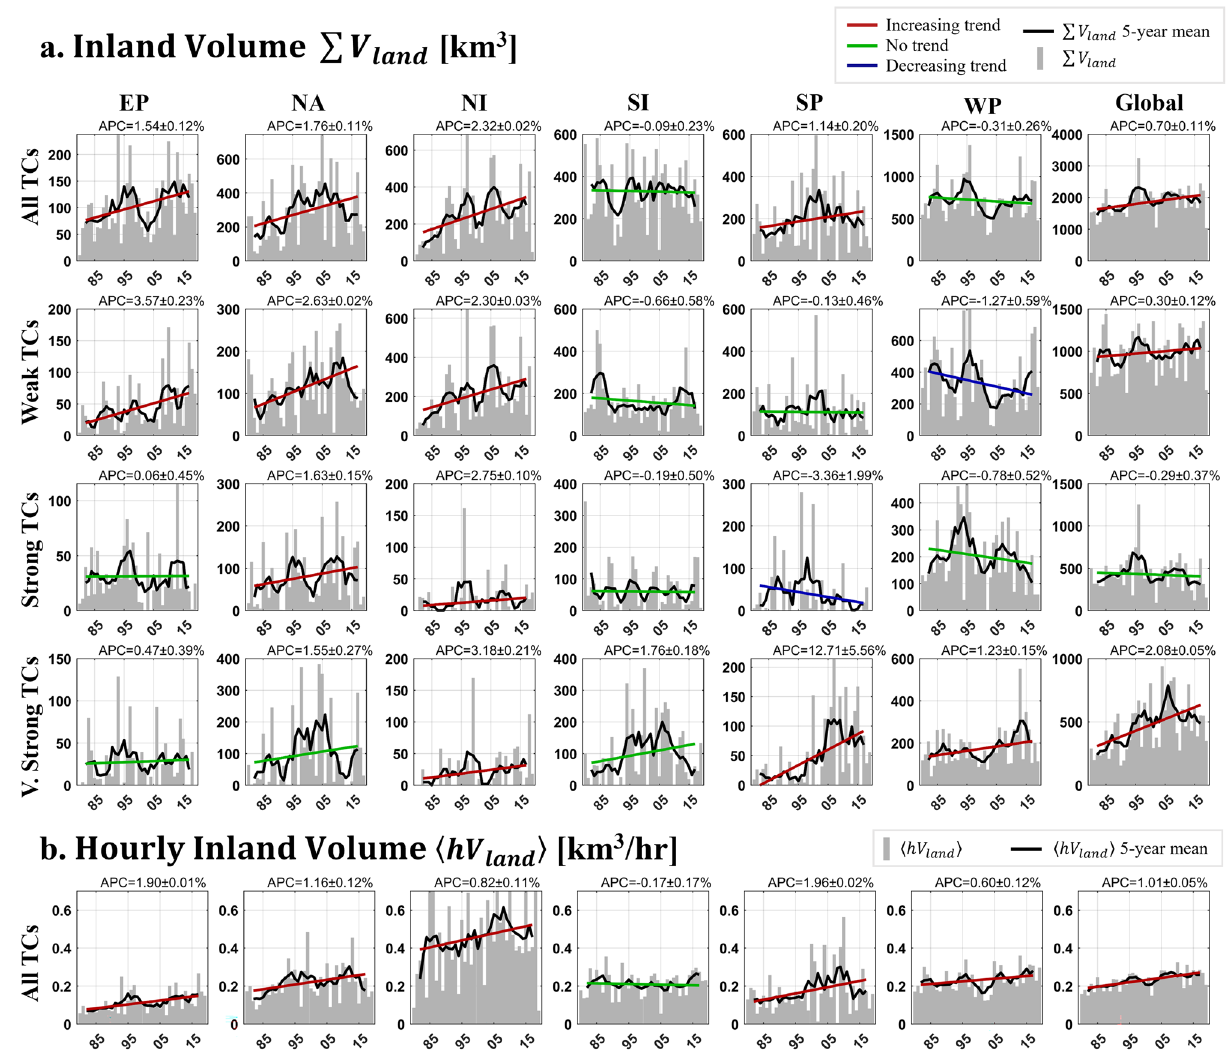
Figure 4. Trend analysis of landfalling tropical cyclone (TC) precipitation volume variables, separated by intensity and basin classifications. Symbology is mostly identical to Figs. 2 and 3, except for gray bars indicating one-year accumulations/averages of landfalling TC precipitation. a. Trends in yearly over land tropical cyclone V land ). b. Trends in mean hourly landfalling precipitation volumes precipitation volume accumulations ( (cid:31) ( (cid:31) hV land (cid:30) ), defined as the amount of precipitation an average TC per category drops over land per hour. Note only the All TCs category is shown as values were similar across all intensity categories, making their differences insignificant. Plainly, because (cid:31) hV land (cid:30) from a Weak TC, a Strong TC, and a Very Strong TC are similar, trends are sufficiently represented in the All TCs category.